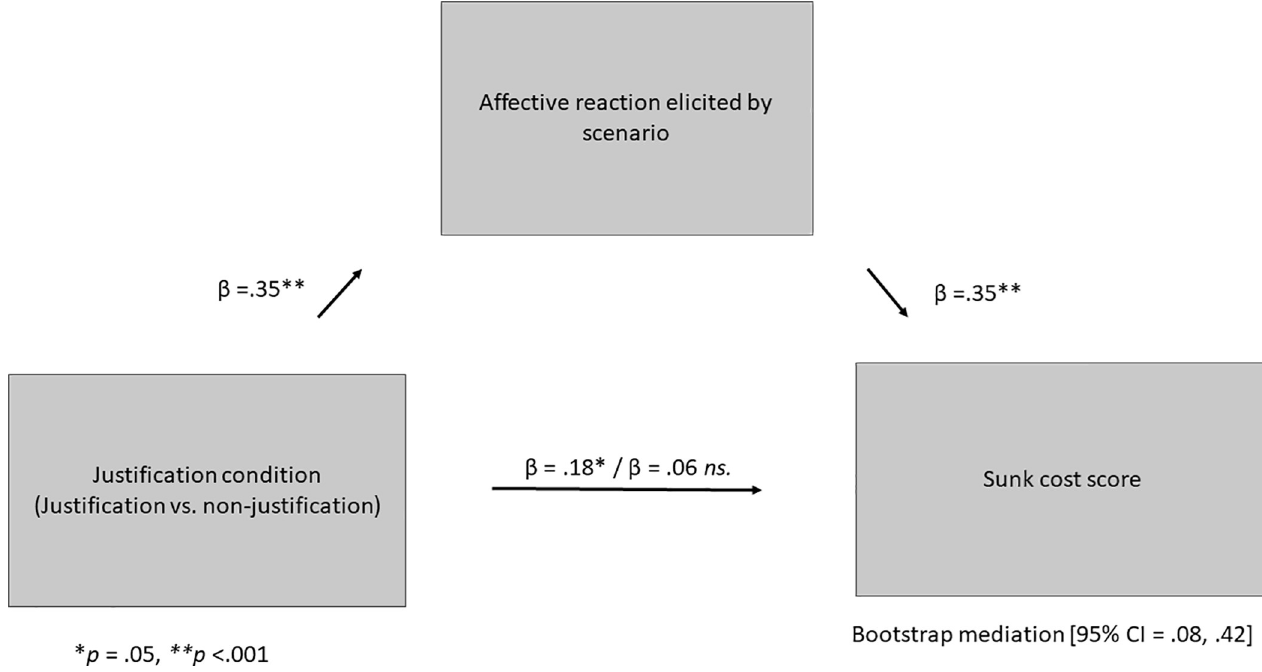
Fig 1. Mediation of the effect of condition (justification vs. non-justification) on sunk-cost scores through affective reaction.